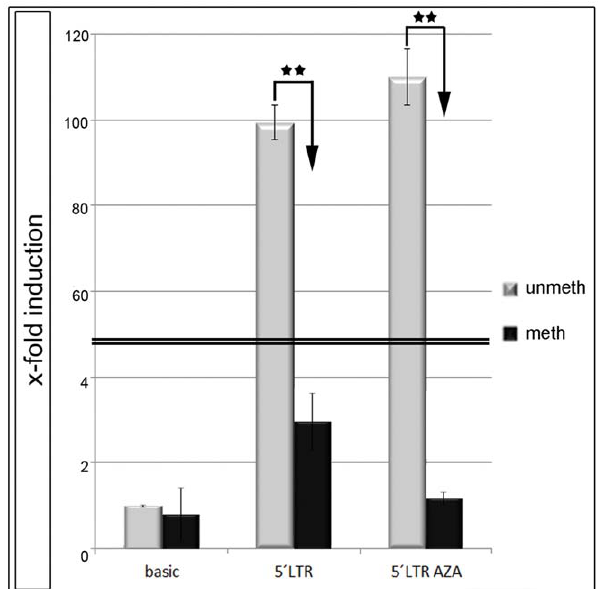
Figure 3. Luciferase Assay. The 5 9 LTR of ERVW-1 was cloned in the pGL3-basic vector and transfected in BeWo cells. 48 hr post transfection cells were analysed. Luciferase activity of the pGL3-basic vector was set to 1. All experiments were repeated at least five times. Histographs show fold-induction to pGL3-basic. (**P , 0.005).